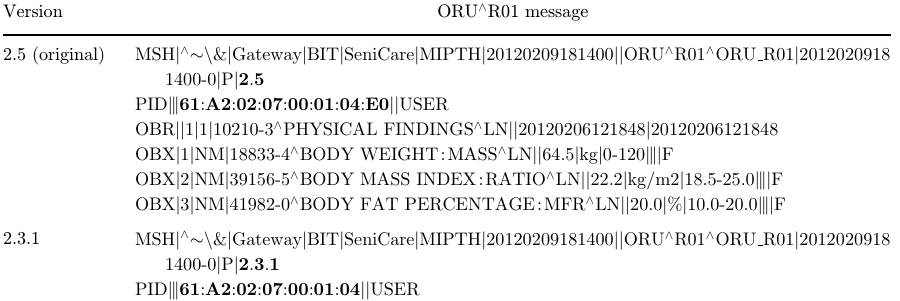
Table 4. Example of ORU ^ R01 message translated from V2.5 to V2.3.1 and V2.7. Version ORU ^ R01